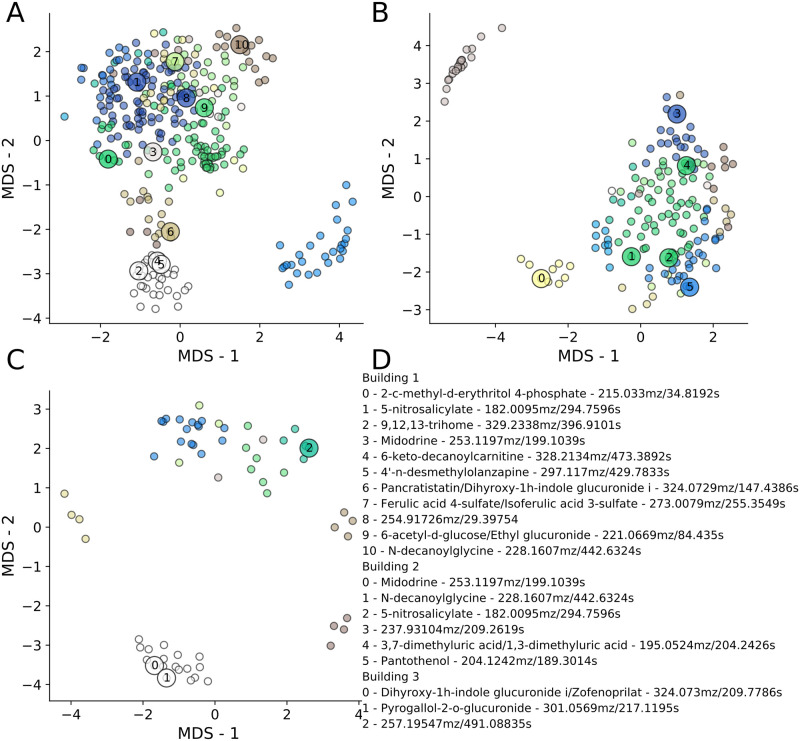
MDS analysis finds many putative metabolites or features that are temporally similar to select important features.MDS analysis of (A) Building 1, (B) Building 2, and (C) Building 3 feature groups with > 15, 8 or 3 (A–C respectively) similar features (as defined by intrabuilding feature-to-feature distance calculations). The ‘important features’ (IFs), to which distances from all other features were calculated, originated from the machine learning models, stability types, and other putatively named metabolites. Colors correspond to features that possess a Euclidean distance < 1.5 and group together. IFs are shown with numbers and large circles, and are labeled in (D). All names are level 2 identifications, unless ending with an ^ corresponding to level 3 identification with ppm error.